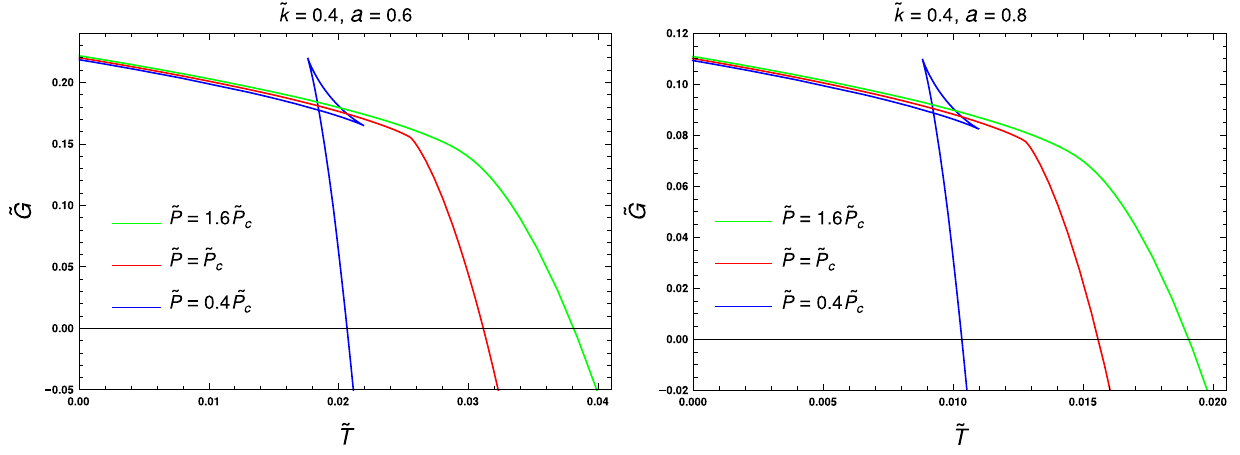
sure ˜ P c . The swallowtail occurs at lower temperature for higher values of a . ˜ P c = 0 . 00368414, 0 . 00184207, respectively, for a = 0 . 6, 0 .